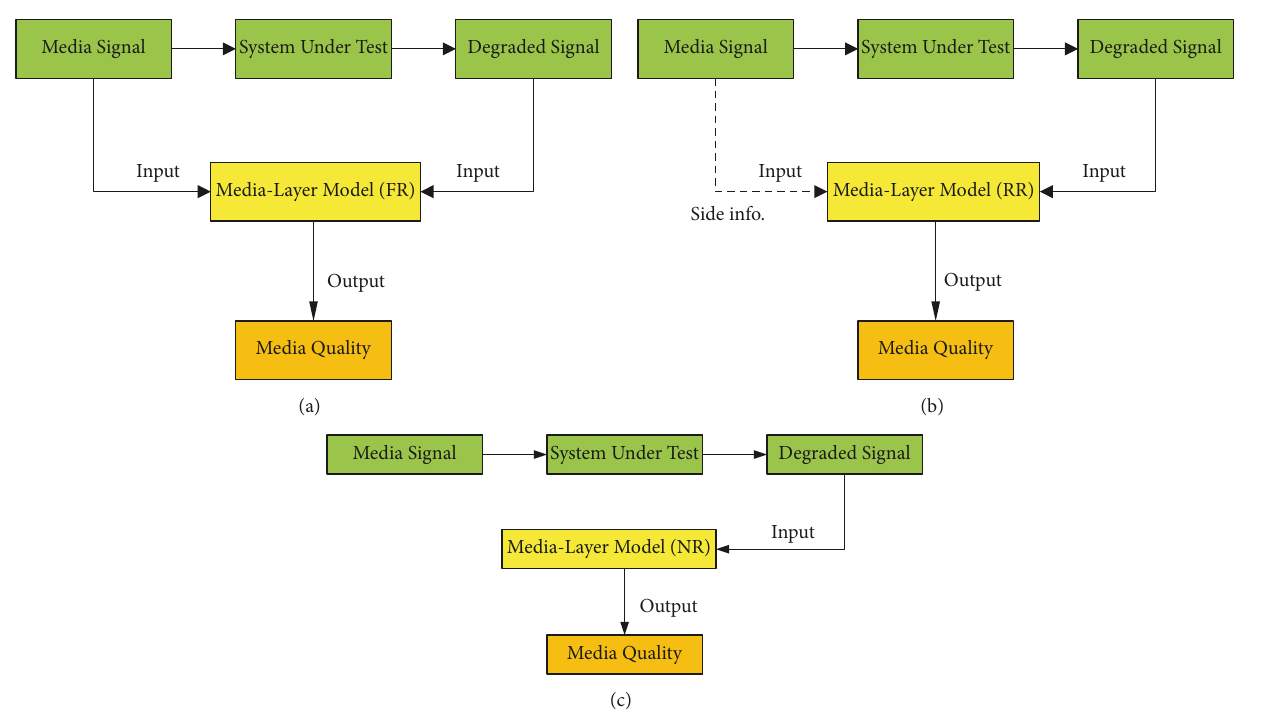
Figure 8: Conceptual view of media layer model: (a) FR methods, (b) RR methods, (c) NR methods.